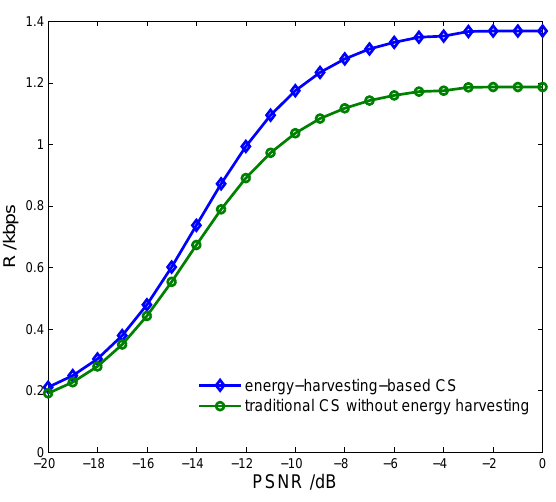
Figure 11. Transmission rate vs. cognitive sensor model with PU signal to noise ratio.